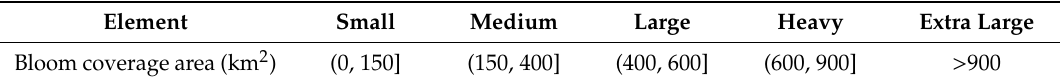
Table 2. Grading system for the algal bloom hazard degree in Taihu Lake.